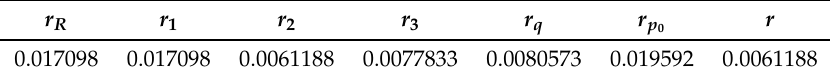
Table 1. Different values of parameters which satisfy Theorem 1.